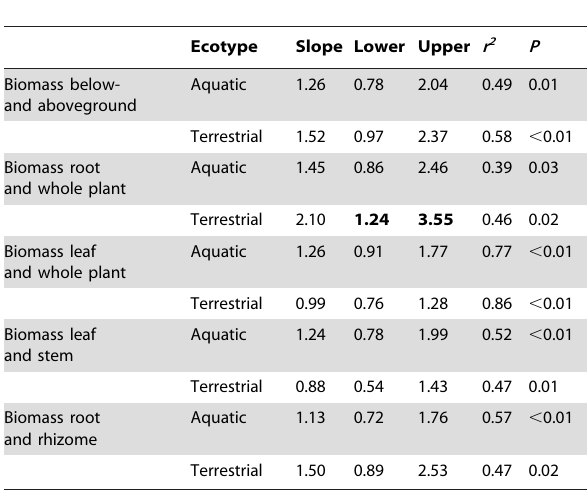
Table 3. The relationships of biomass allocation in different P. australis organs in the aquatic and terrestrial ecotypes (data were log 10